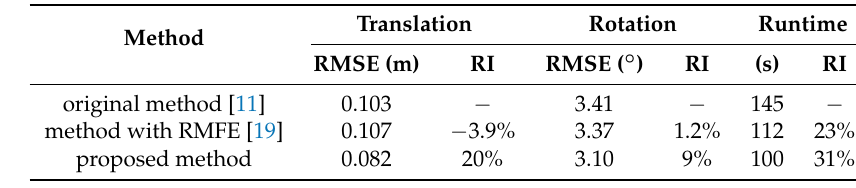
Table 2. Trajectory results of RGB-D SLAM with fr1/360 sequence.